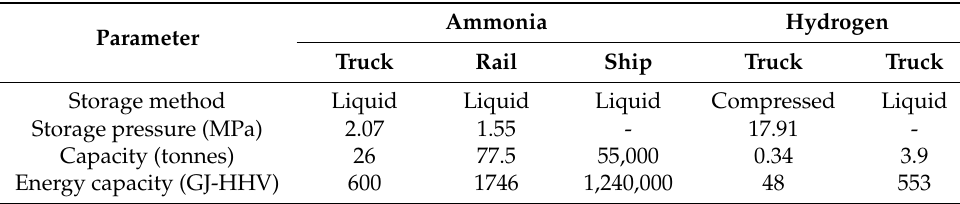
Table 4. Differences in NH 3 and H 2 transport methods [44].